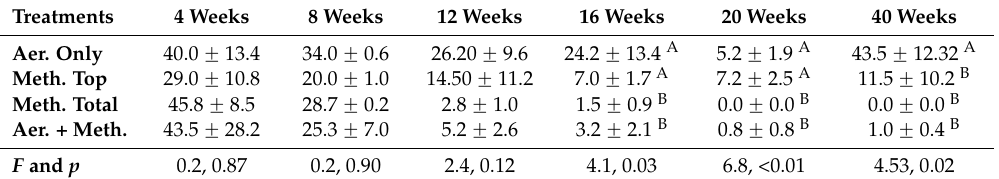
Table 6. Mean numbers ( ˘ SE) of adult C. ferrugineus collected in grain trier samples at different times after bins were loaded with wheat that was either treated with aeration only, the top 50 cm-treated with methoprene, methoprene treatment to all the wheat in a bin, or aeration plus complete treatment with methoprene on all grain in the bin. Means within columns with the same upper case letter, for which there was a significant ( p < 0.05) F-statistic, are not significantly different (LSD test, p < 0.05, SAS Institute, degrees of freedom for analysis within date for treatment were 3, 12).